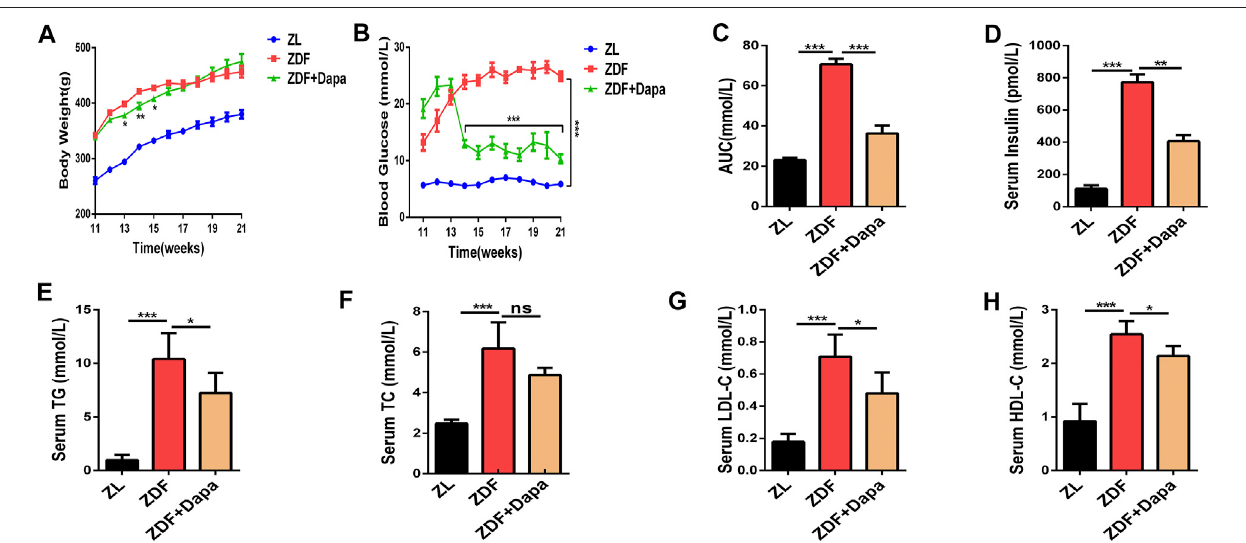
FIGURE1| Dapagli fl ozinimprovesglucoseintoleranceandregulateslipidmetabolisminZDFrats. (A) Bodyweightwasrecordedeveryweekandbodyweightgain was measured at the end of the 21st week. (B) Blood glucose levels were monitored throughout the entire experiment. (C) The area under the curve (AUC) of blood glucosewascalculatedby thetrapezoidalmethod. (D) Serum insulin levels wereevaluatedin groups. (E – H) Serum levels ofTG,TC, LDL-C, and HDL-C wereevaluated in groups. ZL: ZL rats as a normal control, ZDF: ZDF rats fed with a high-fat diet, ZDF + Dapa: dapagli fl ozin-treated ZDF rats. Data are expressed as the means ± SEM of fi ve animals per group. * p < 0.05, ** p < 0.01, and *** p < 0.001 compared with the ZDF rat